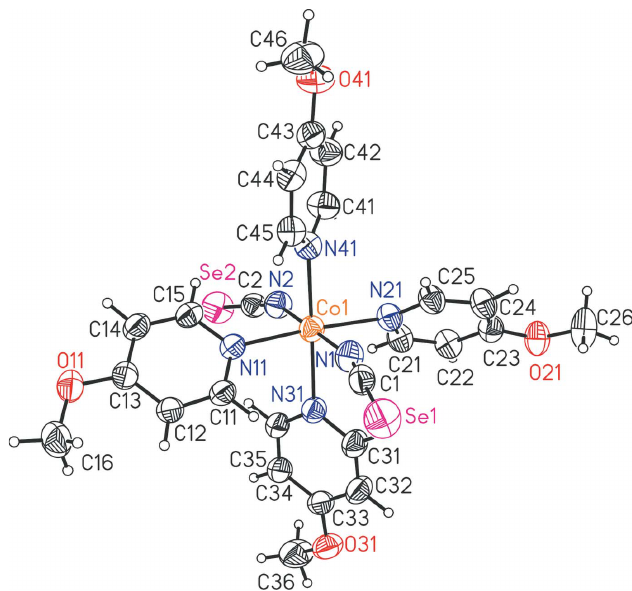
Figure 1 Crystal structure of the title compound with labeling and displacement ellipsoids drawn at the 50% probability level.